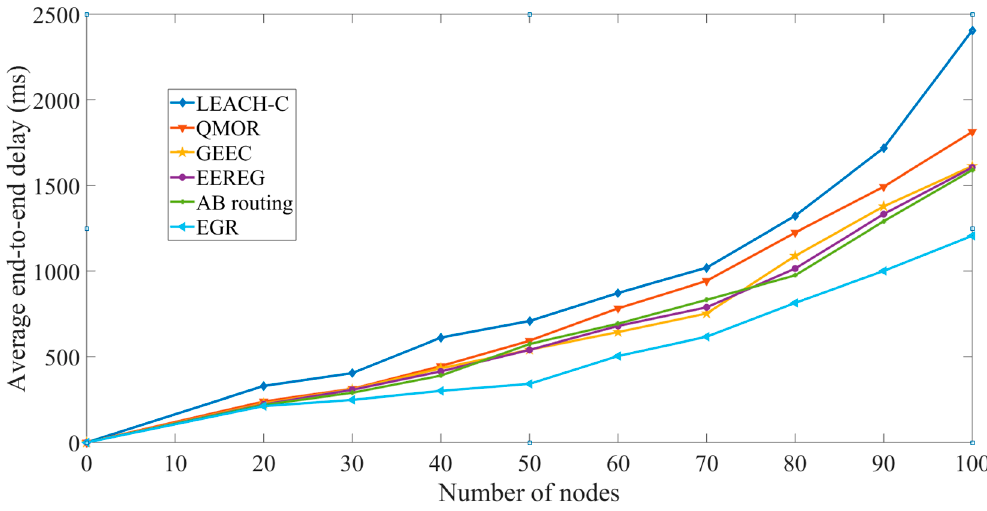
Figure 17. Average end-to-end delay vs. the number of nodes.